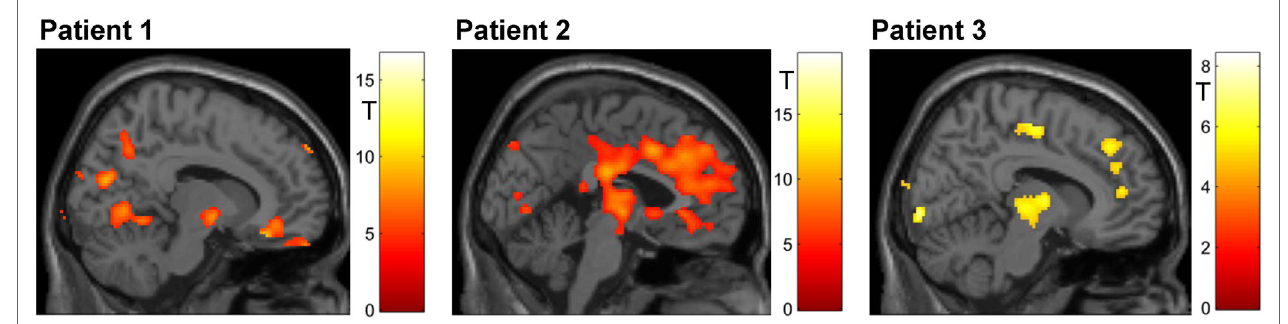
FIGURe 5 | Mapping of linear increase over days ( p < 0.05, FWe corrected) . The training led to increased activity in clusters encompassing midbrain structures (all patients) and – in patients 2 and 3 – in the ACC.